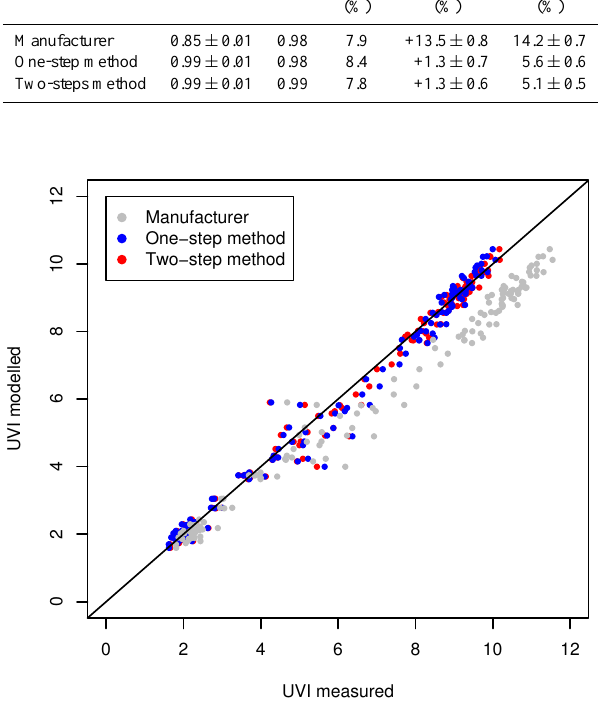
Fig. 5. Relationship between UVI estimations derived from Li- bRadtran/UVSPEC model and experimental UVI data obtained ap- plying the manufacture’s factor and the two calibration procedures. The solid line is the zero bias line, unit